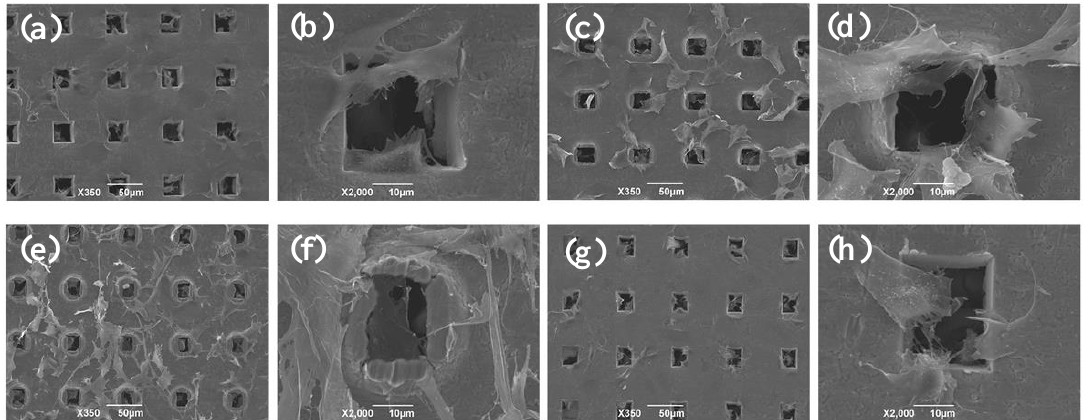
Figure 4. SEM images of MC3T3-E1 cells seeded on the Ti membrane on day 3. ( a ) MC3T3-E1 cells were seeded on the head side. ( c ) The opposite side of ( a ). ( e ) MC3T3-E1 cells were seeded on the tail side. ( g ) The opposite side of ( e ) (scale bar represents 50 μm). ( b , d , f , h ) are higher magnification views of ( a , c , e , g ) (scale bar represents 10 μm).